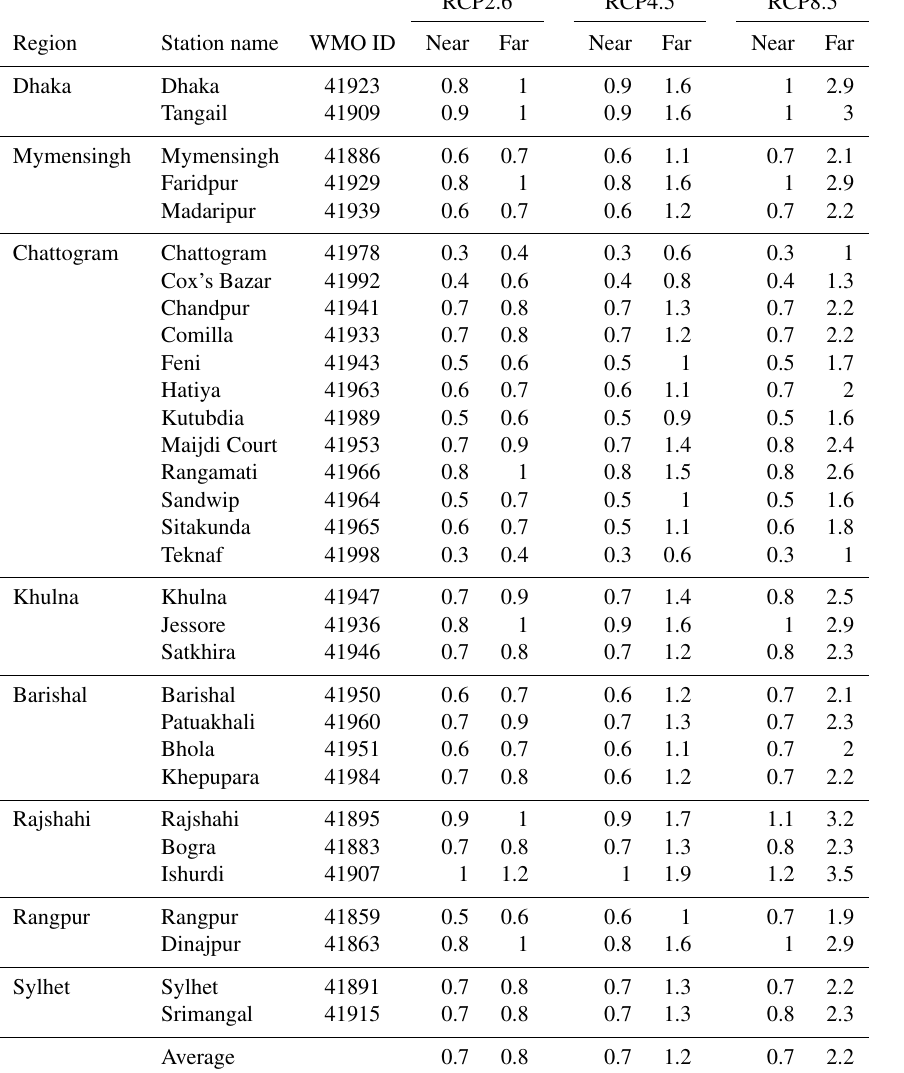
Table 1. Ensemble mean change in maximum temperature (unit: ◦ C) for the pre-monsoon season (March-May) in Bangladesh for the near future (2021–2050) and the far future (2071–2100) compared to the base period 1981–2010. Projected changes are shown for three emission scenarios: RCP2.6, RCP4.5, and